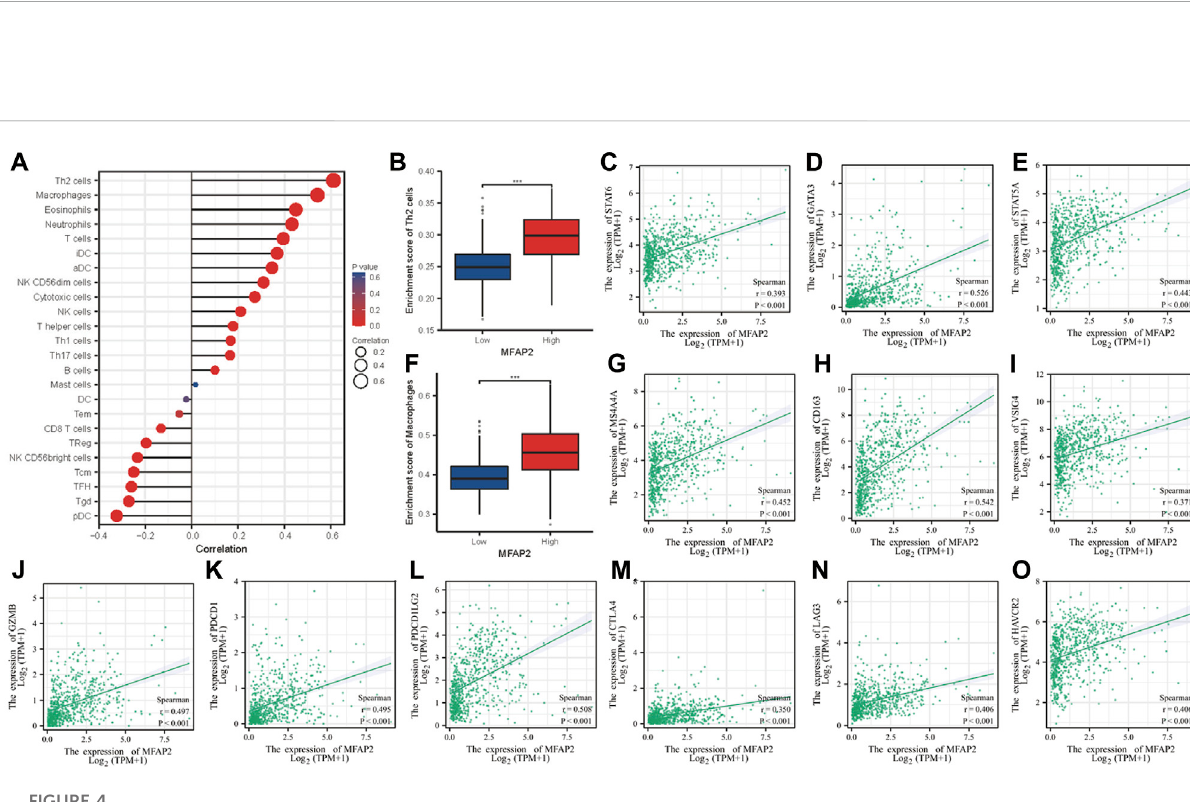
FIGURE 4 Associationbetweentumor-in fi ltratinglymphocytesandMFAP2inglioma. (A) Associationbetweenabundanceofthe24typesofimmunocytes and MFAP2 expression level. (B) Th2in fi ltration level in thehigh- and low-MFAP2 expression groups inthe TCGA cohort. (C – E) Correlation between MFAP2 expression and Th2 markers. (F) Macrophage in fi ltration level in the high- and low-MFAP2 expression groups in the TCGA cohort. (G – I) CorrelationbetweenMFAP2expressionandM2-likemacrophagemarkers. (J – O) CorrelationbetweenMFAP2expressionandTcellexhaustion markers. p -value signi fi cance codes: *** p ≤